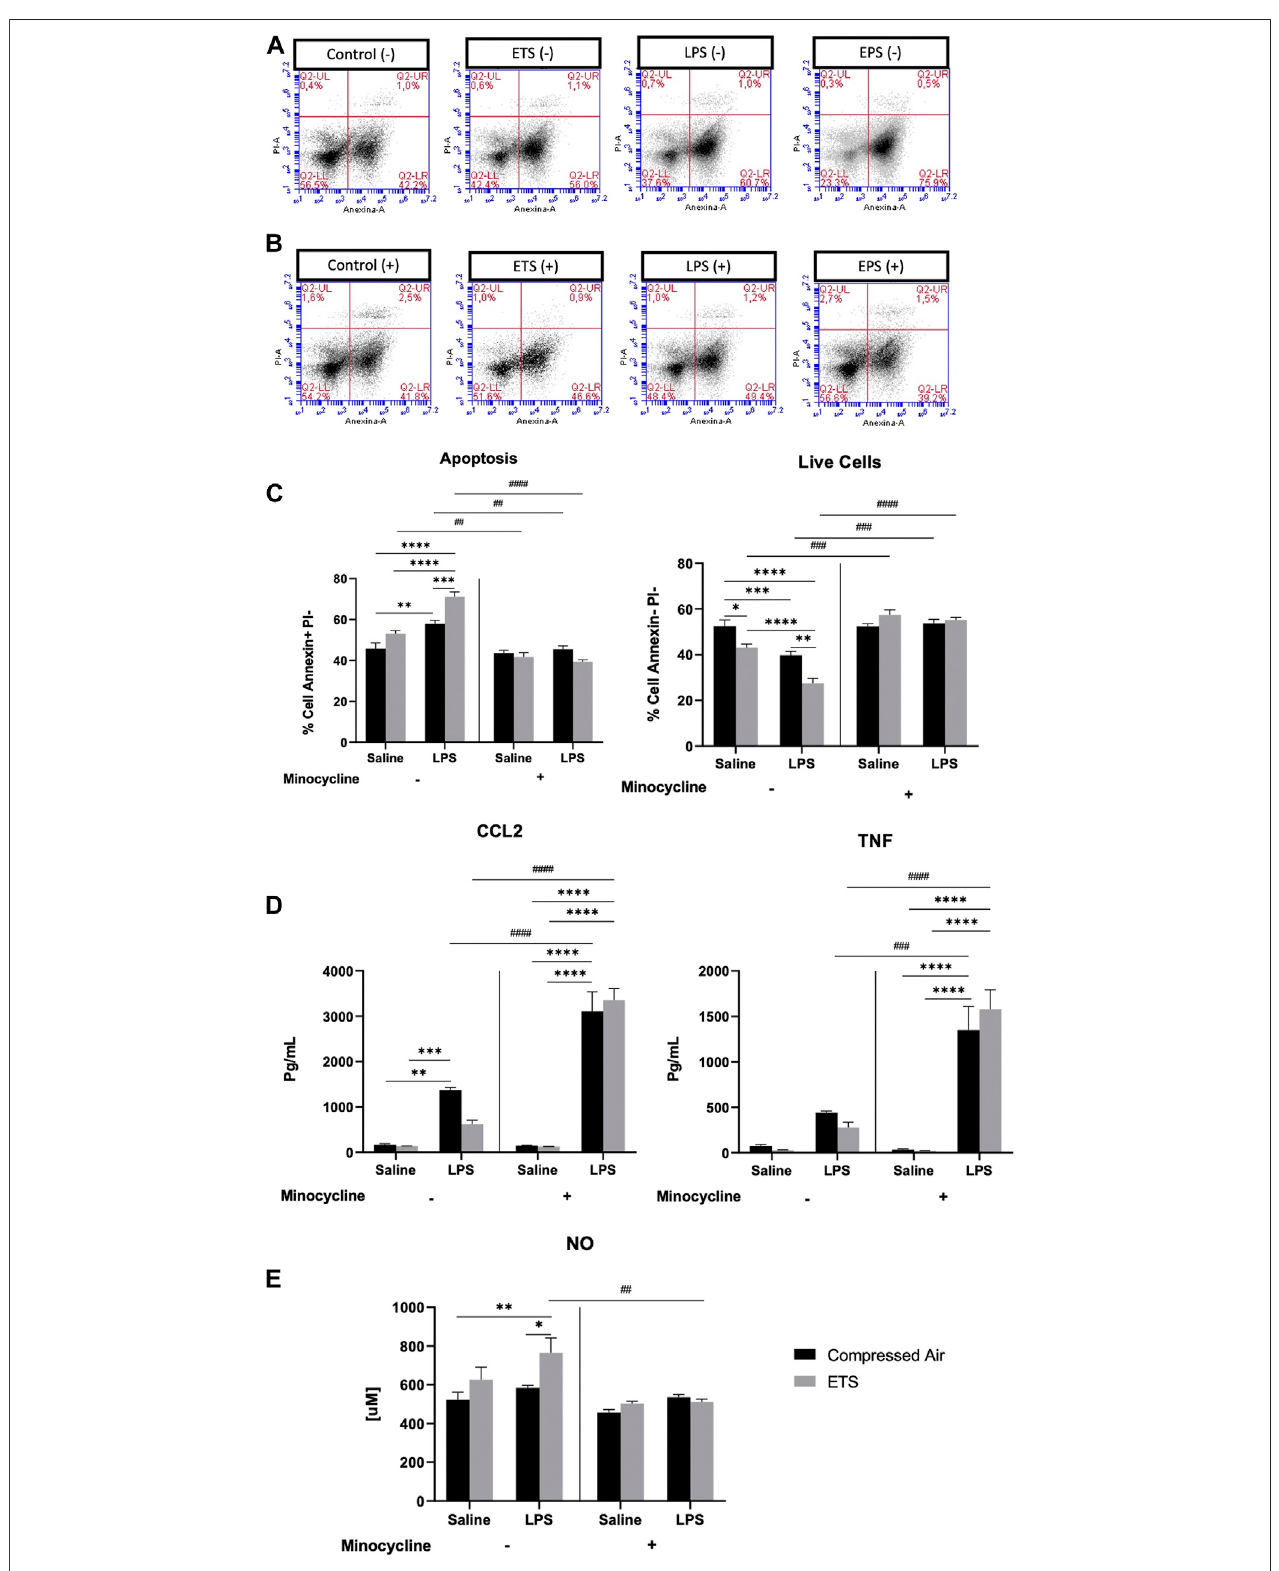
FIGURE 3 | Mixed cell culture (mixed neuron-glia culture) from animals exposed or not to environmental tobacco smoke. After maturation, cells were treated with